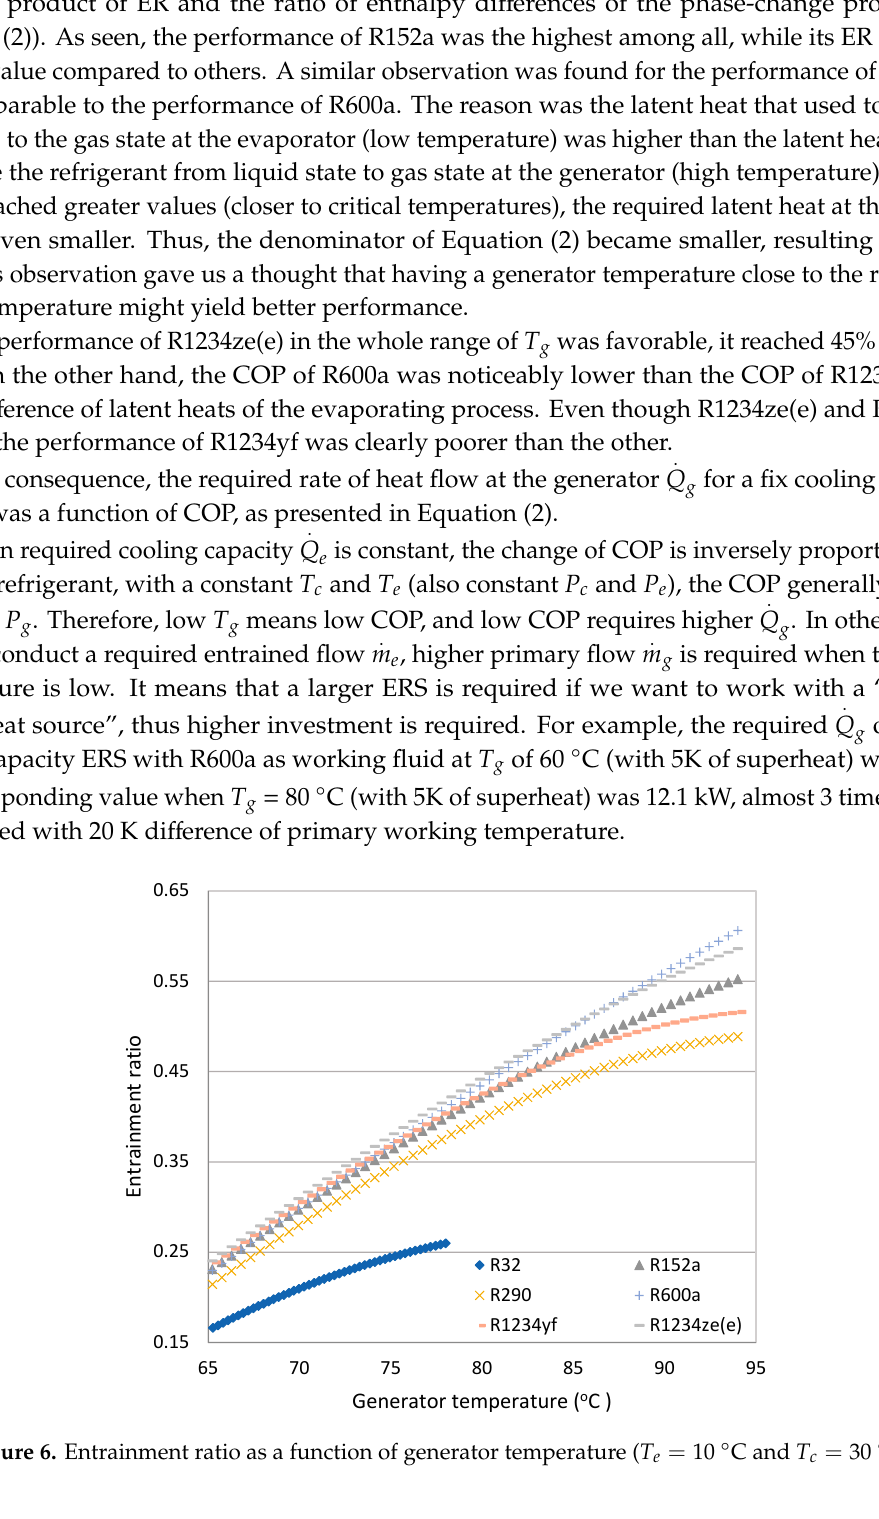
Figure 6. Entrainment ratio as a function of generator temperature ( 𝑇 (cid:3032) = 10 °C 𝑎𝑛𝑑 𝑇 (cid:3030) = 30 °C).